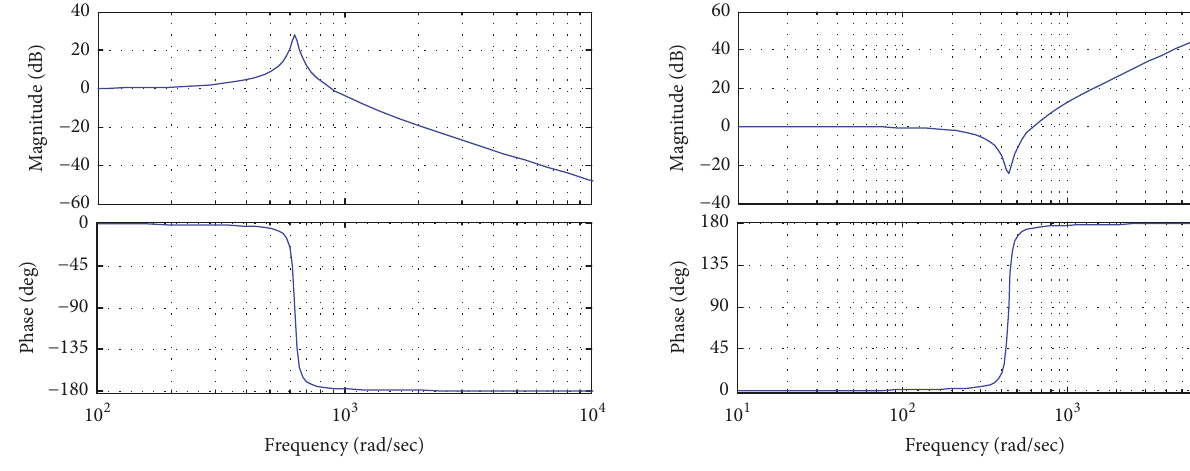
Figure 3: Bode diagram of typical oscillating element. Figure 4: Bode diagram of typical differential